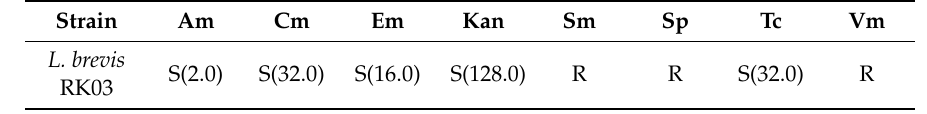
Table 3. Antibiotic susceptibilities of L. brevis